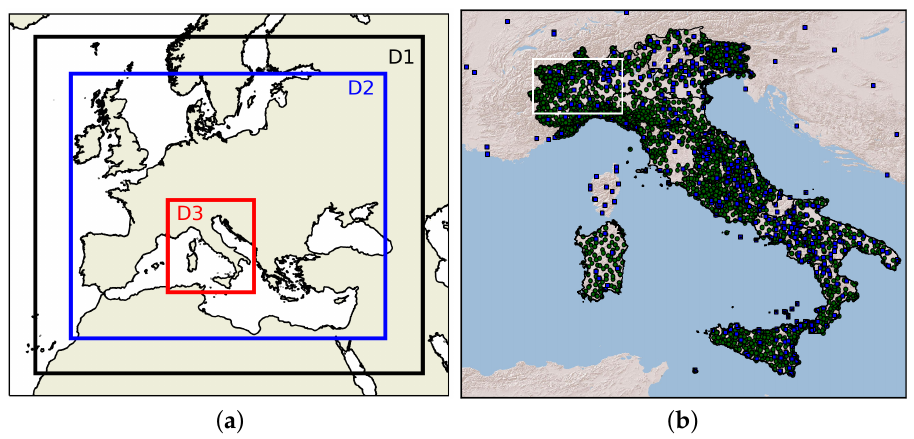
Figure 5. WRF domains ( a ) adopted for the numerical simulations: D1 (black), D2 (blue) and D3 (red) with a horizontal resolution of 22.5 km, 7.5 km and 2.5 km, respectively. Spatial distribution of ZTD observations (blue squares) and temperature data from weather stations (green points) assimilated in the WRF model ( b ). The white rectangle indicates the study area (NW) where the validations are